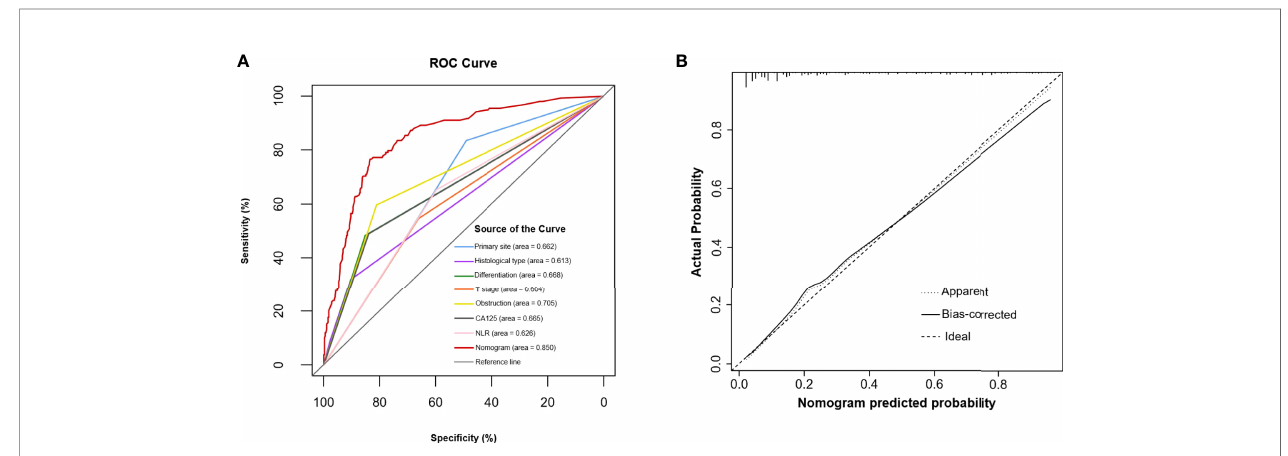
FIGURE 3 | (A) The predictive accuracy of the model was assessed by a ROC curve. (B) Calibration curve of the prediction